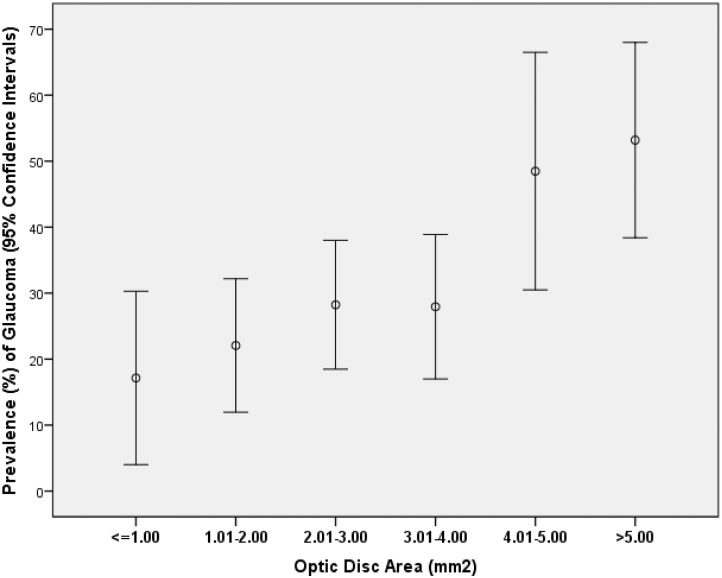
Prevalence of glaucomatous optic nerve damage in highly myopic individuals stratified by optic disc size.In univariate analysis, the prevalence of glaucomatous-type discs increased significantly with optic disc area (P<0.001).